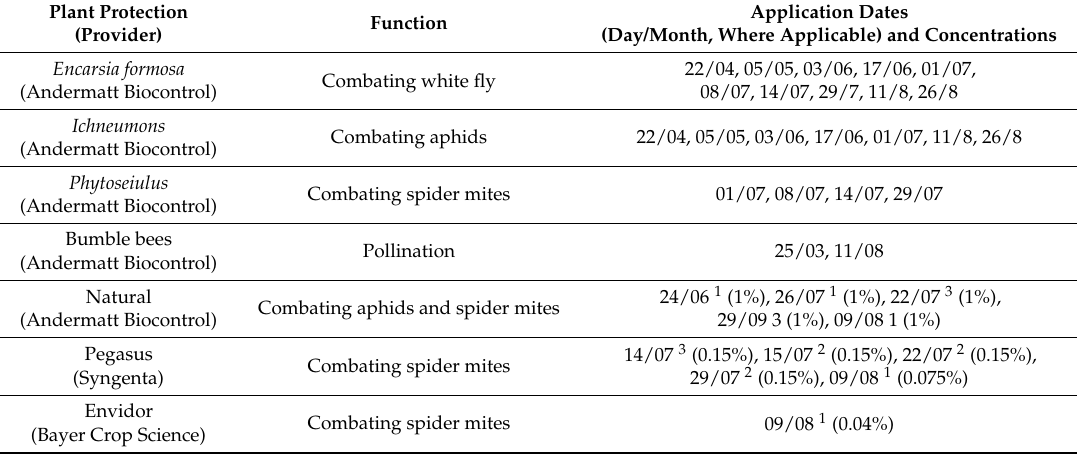
Table A1. Application of beneficial organisms, pesticides and their applied concentrations on tomato plants in “Wädenswil aquaponic system” in